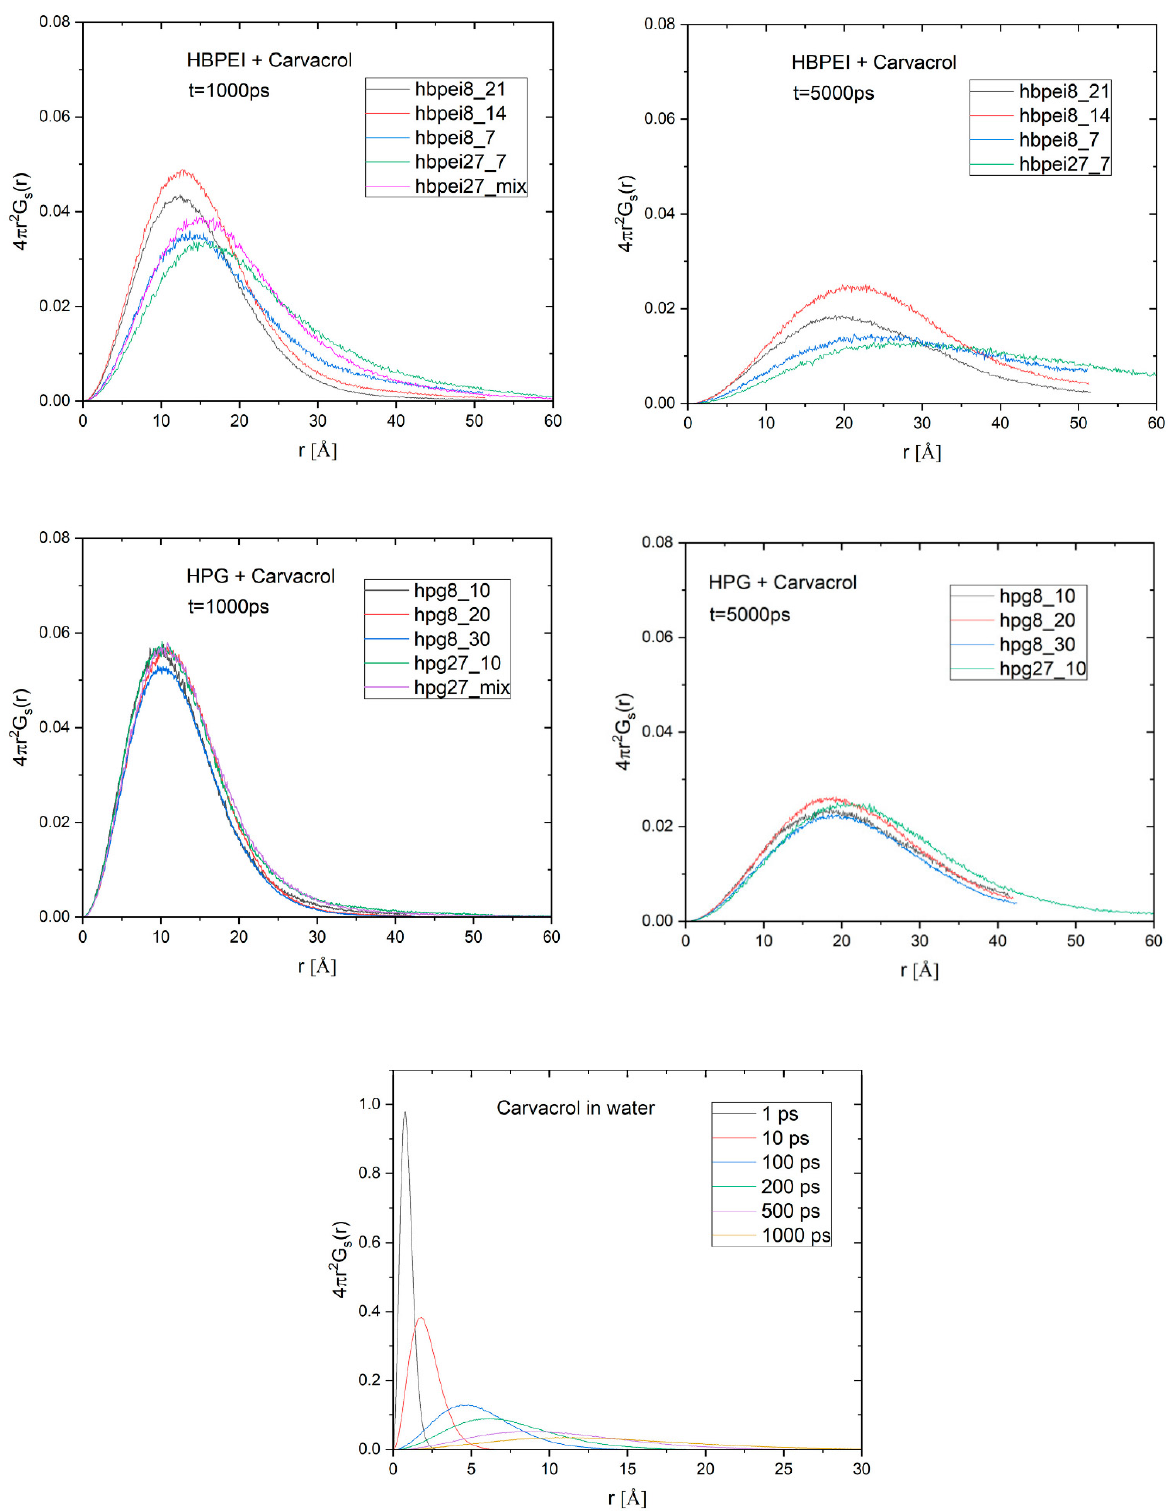
Figure 5. Self-diffusion van Hove functions, 4 π r 2 G s (r; t), of carvacrol in HBPEI (top) and HPG (middle) systems for time scales t = 1 ns and 5 ns as functions of the average displacement of carvacrol molecules, r . Similar functions for aquatic carvacrol solutions at times between 1 ps and 1 ns are also shown (lower panel).